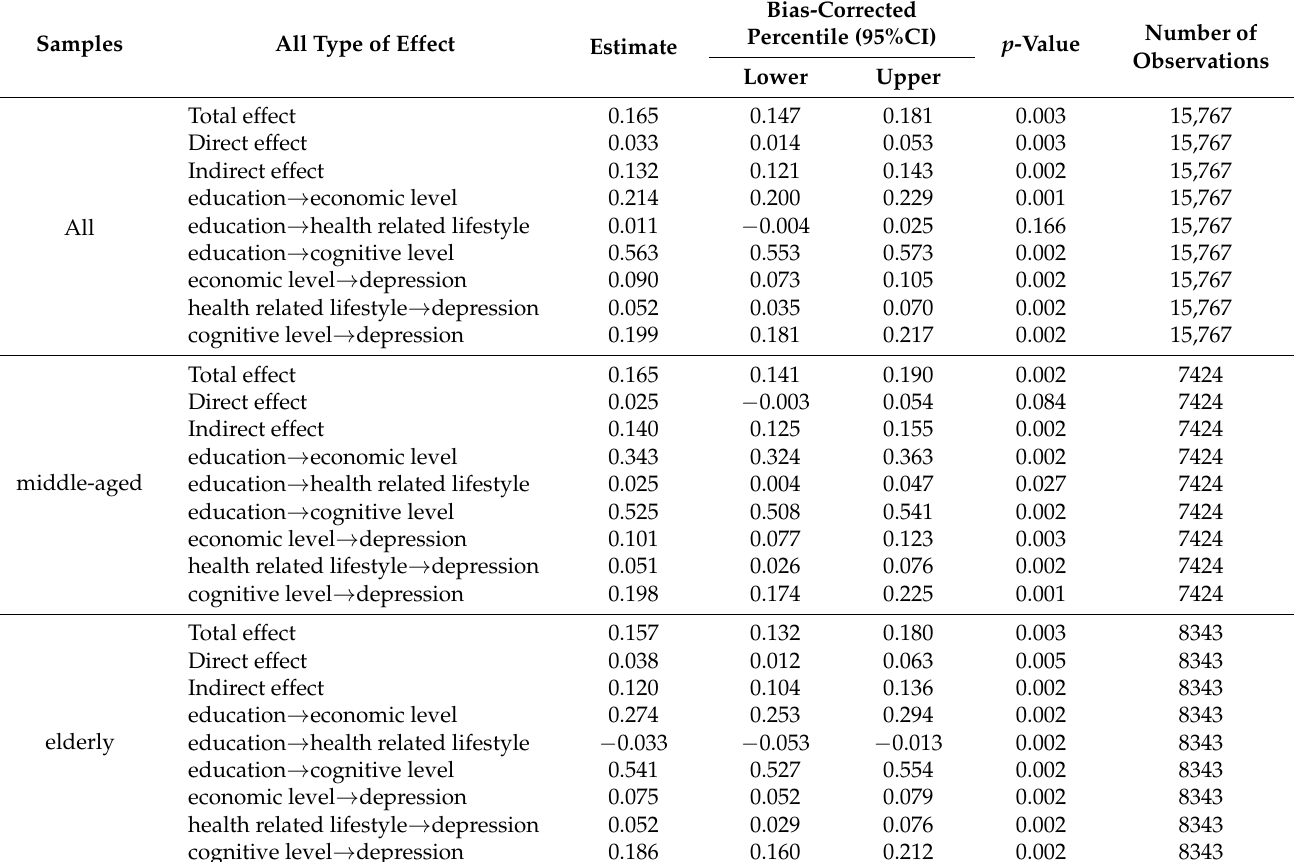
Table 6. Results of multiple mediation tests: total, direct, and indirect